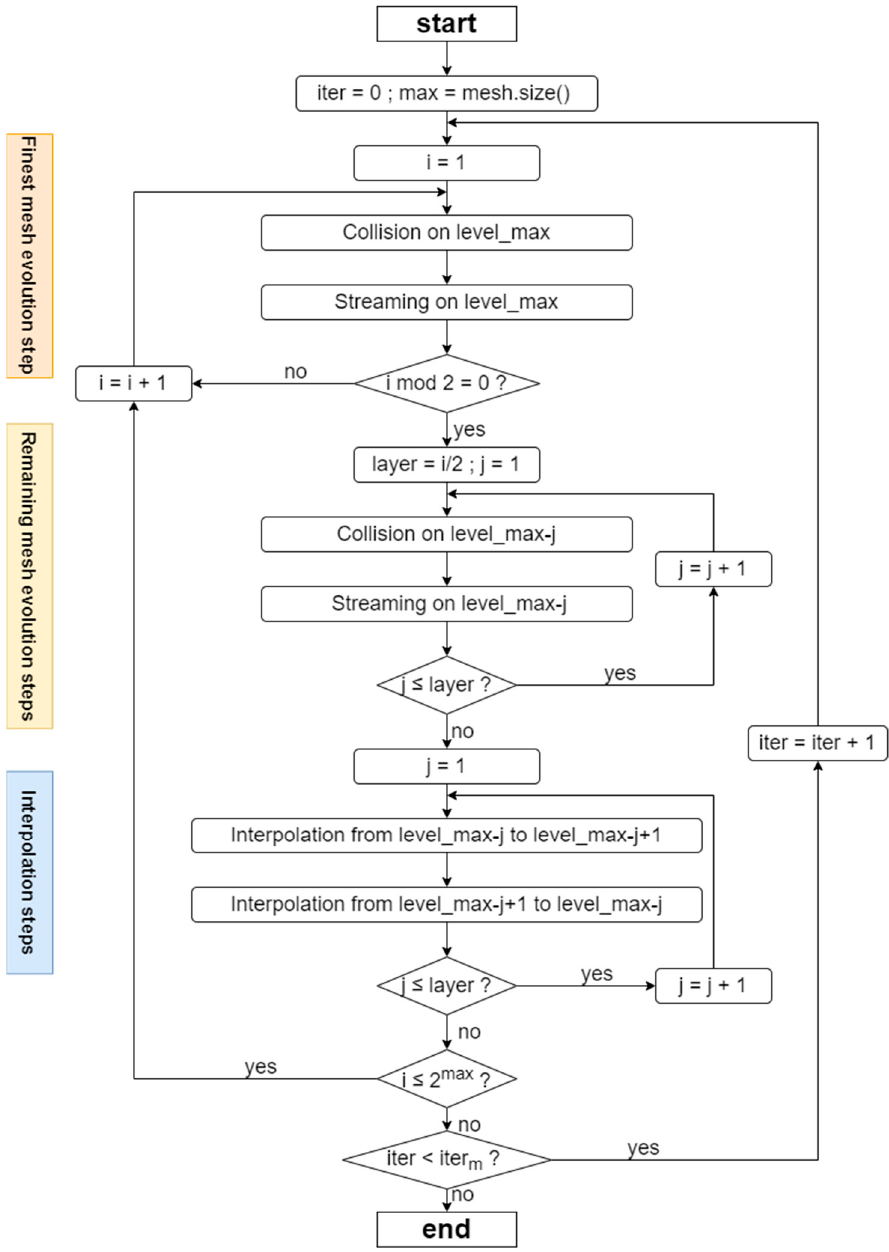
Figure 4. Flowchart of the DC method. Outside the loop body, the code initializes the variable iteration round iter to 0 and max is set to the highest grid-refinement level. Within the loop body, the full evolution of one time iteration step is divided into three modules, which are the finest mesh evolution step, remaining mesh evolution steps and interpolation steps. The ordinal number after level_variable represents the refinement level of the current uniform grid. A set of operations on the current grid completes the tasks of a module. Each module schedules the execution of tasks based on the loop control variables and conditional control variables in the flowchart. iter _ m represents the maximum number of iterations.